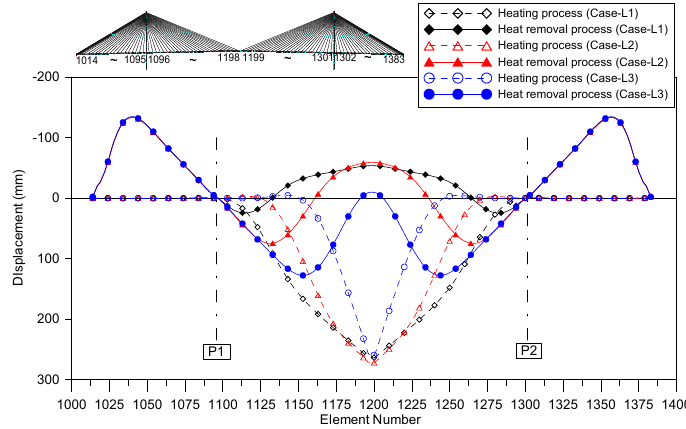
Figure 10. Girder deflections generated by thermal prestressing for different heating regions.